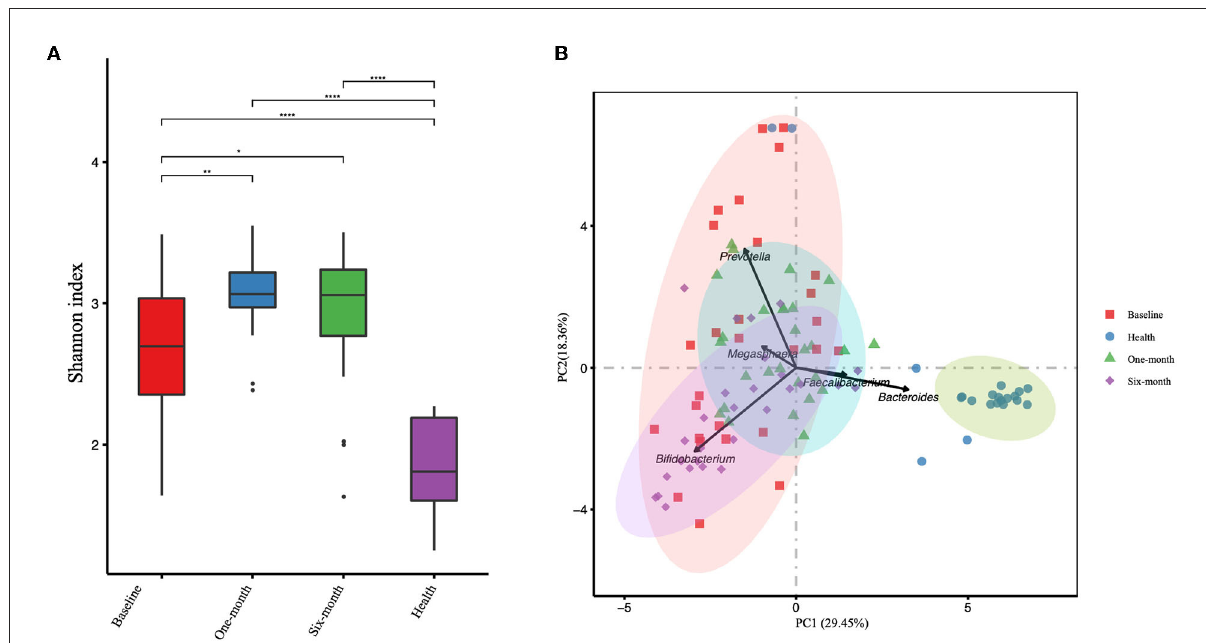
FIGURE2 The gut microbial α -diversity analyzed by Shannon index (A) and the principal component analysis (PCA) (B) of the patient group and healthy group are presented. Three timepoints of the patient group are presented, including baseline, 1-month, and 6-month intervention. * P -value < 0.05, ** P -value < 0.01, **** P -value <